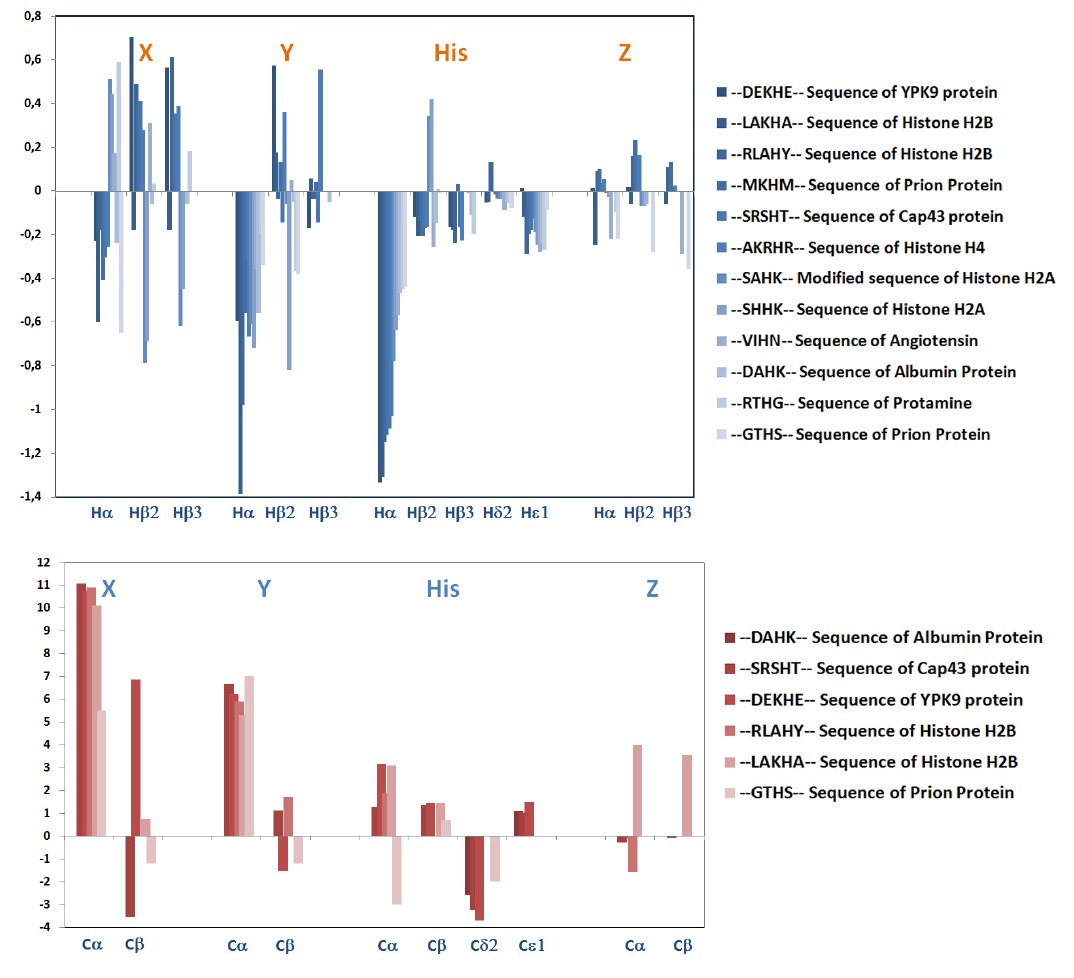
Figure 2. Plot of 1 H- and 13 C-NMR chemical shift variations ( Δδ = δ selected analogous sequence with Ni(II) bound in a 4N based coordination